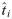
Loop and protrusion geometry.The chain (shaded in cyan) is modeled by spheres (blue dashed circles), here with link length l equal to diameter w. Chain joint locations are marked as ri, for i = 0, …, N. Arrows along chain links indicate orientations t^i. The green wedge depicts the cross-section of the looping volume δr that is coplanar with looping volume orientation u^0. The protrusion is positioned on the second link (k = 2). In-phase-with-u^0 (γ2 = 0°) and out-of-phase (γ2 = 180°) positions are illustrated by the solid and dashed red circles, respectively. In this schematic representation, all chain joints are depicted in the 2D plane defined by u^0 and t^1.